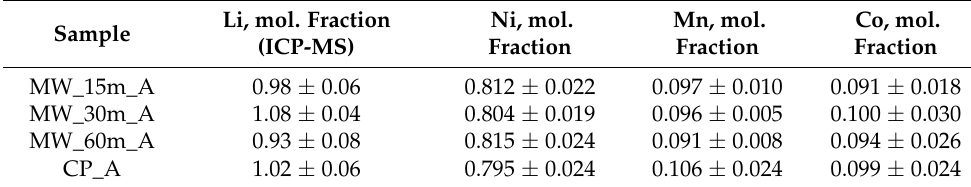
Table 2. ICP-MS and EDX quantitative elemental analysis for the NMC811 samples obtained via different routes.